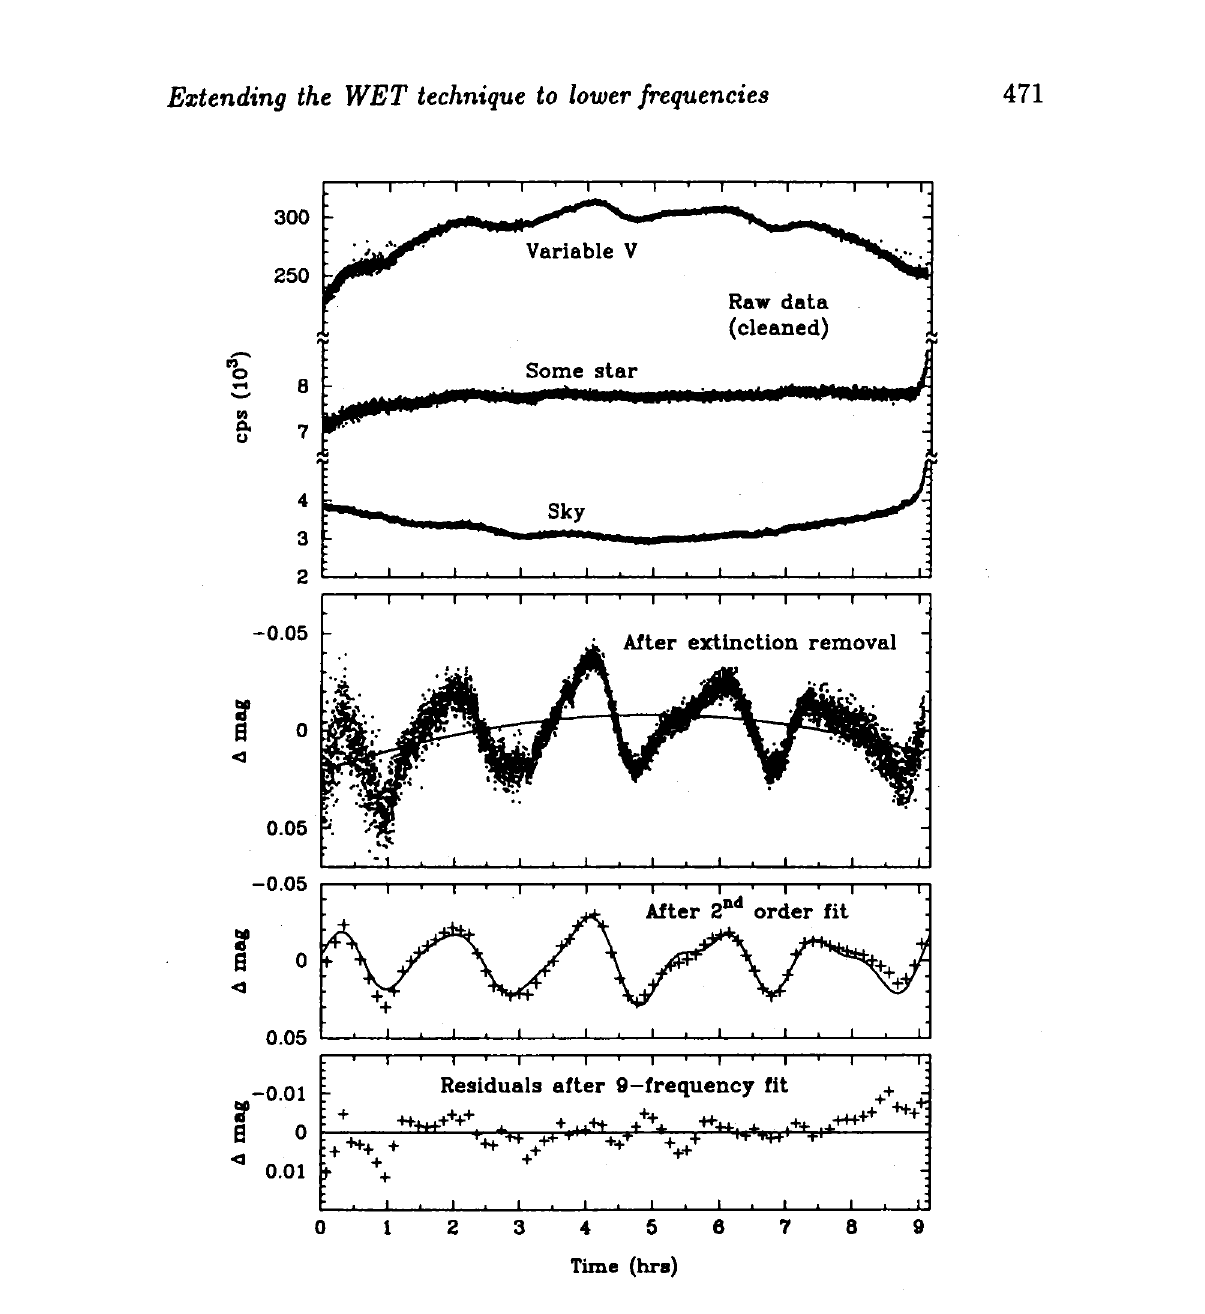
Fig. 1-b. Raw and reduced data of FG Vir obtained with the WET techniques. The standard Texas reduction (middle panel) leaves some drift as well as residual extinction effects. The overall nine-frequency fit suggests a second-order polynomial to eliminate this